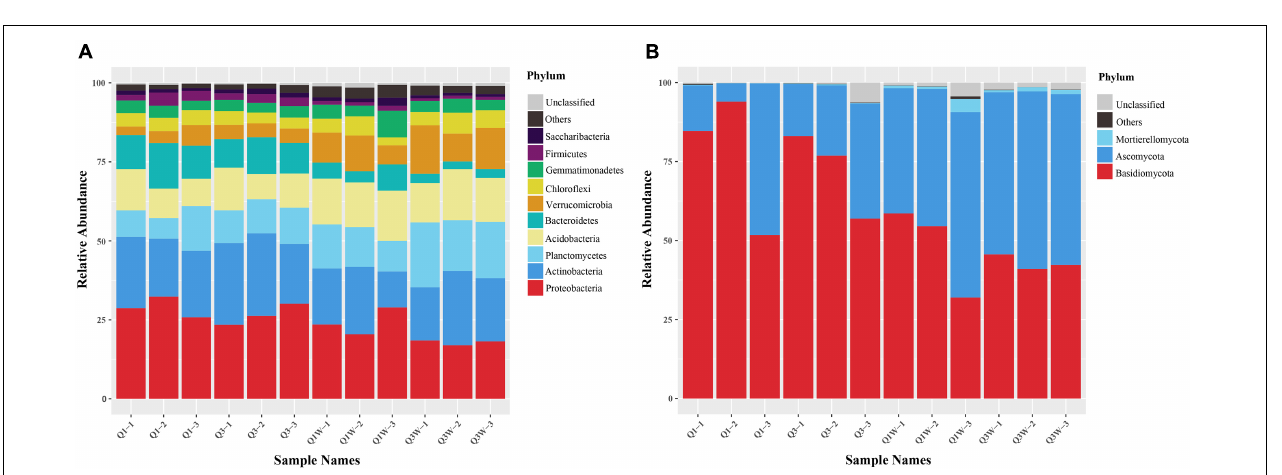
Q3W), but that of Mortierellomycota reached an obviously